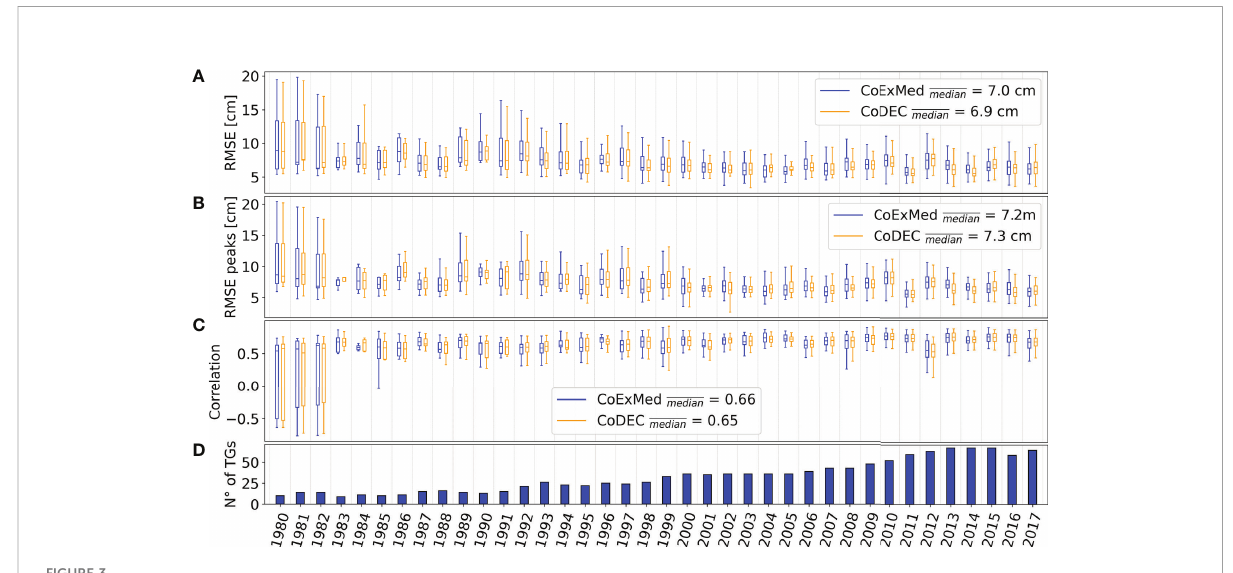
FIGURE 3 Analysis of differences observed between tide gauge signal and both simulated sea surface elevation from CoExMed (blue boxes and lines) and CoDEC (orange boxes and lines). The fi rst three panels show annual boxplots for RMSE (A) , RMSE peaks (B) and Pearson correlation coef fi cient (C) statistical indicators, and the median represents the mean of the median indicators. The box extends from the fi rst to third quartile values of the data, with a line at the median. Lower (upper) whiskers are set to the fi rst datum greater than Q1 - 1.5*IQR (Q3 + 1.5*IQR), where IQR is the interquartile range. The lowest panel (D) shows the annual number of tide gauges